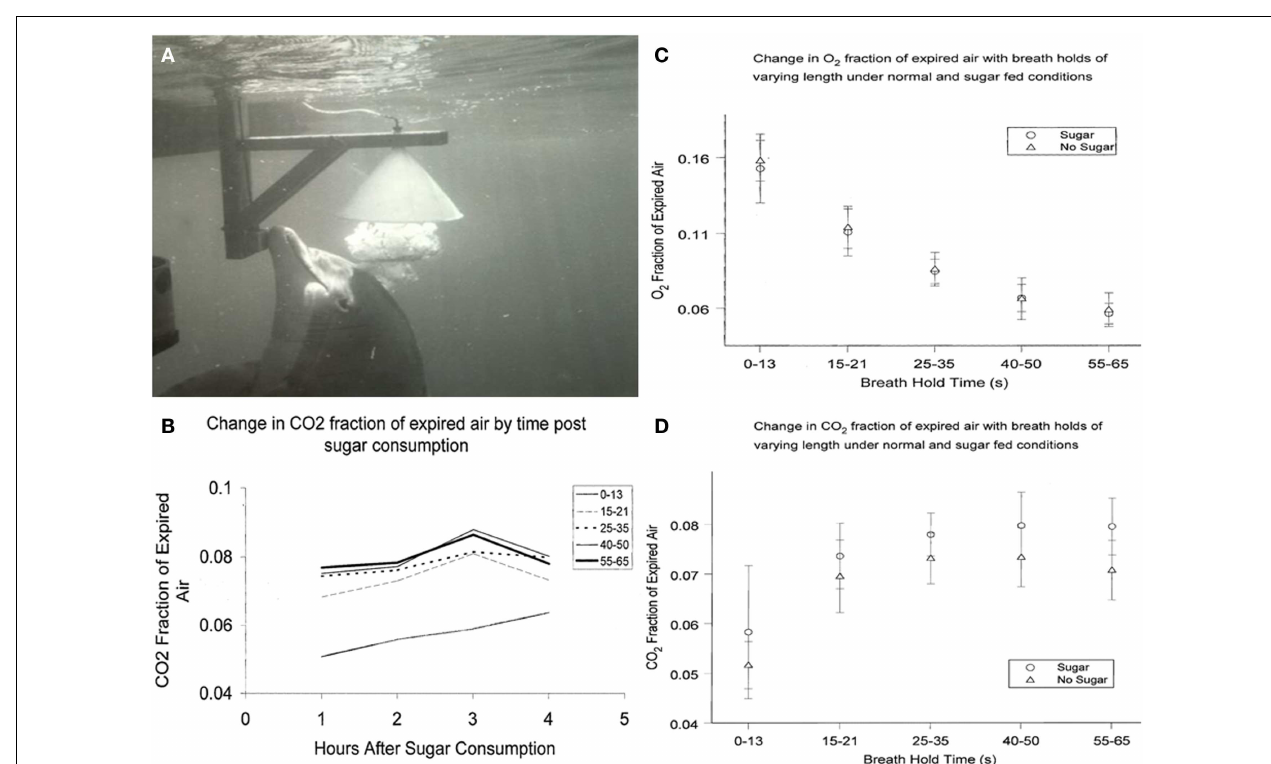
indicators of CO 2 total expired. (C) Change in O= fraction of expired breath 1–4h after sugar consumption. (D) Change in CO 2 fraction of expired breath 1–4h after sugar